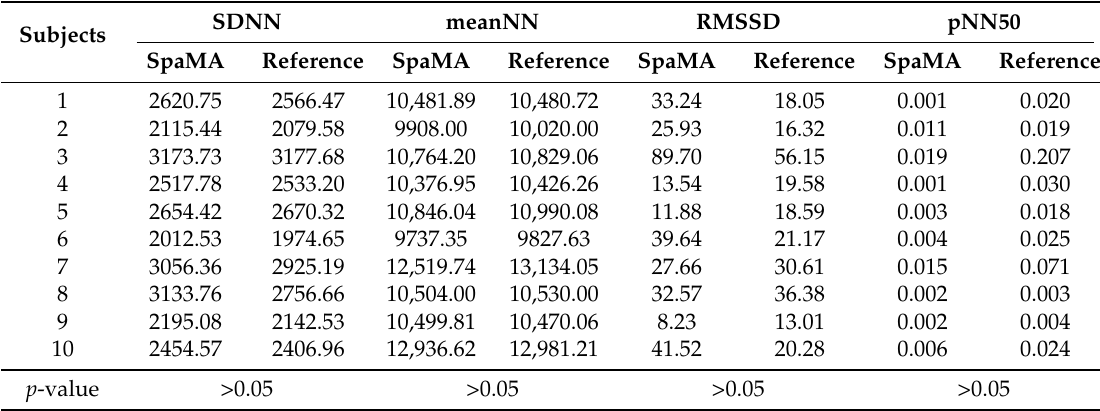
Table 5. Time domain HRV analysis comparison: SpaMA vs. reference